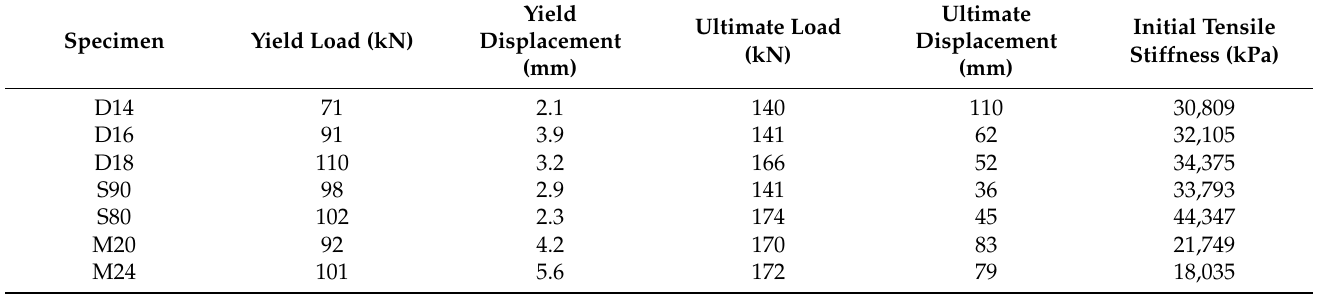
Figure 9. A typical force–displacement curve behavior of a T-stub. Figure 8. Force–displacement test curves for T-stubs.